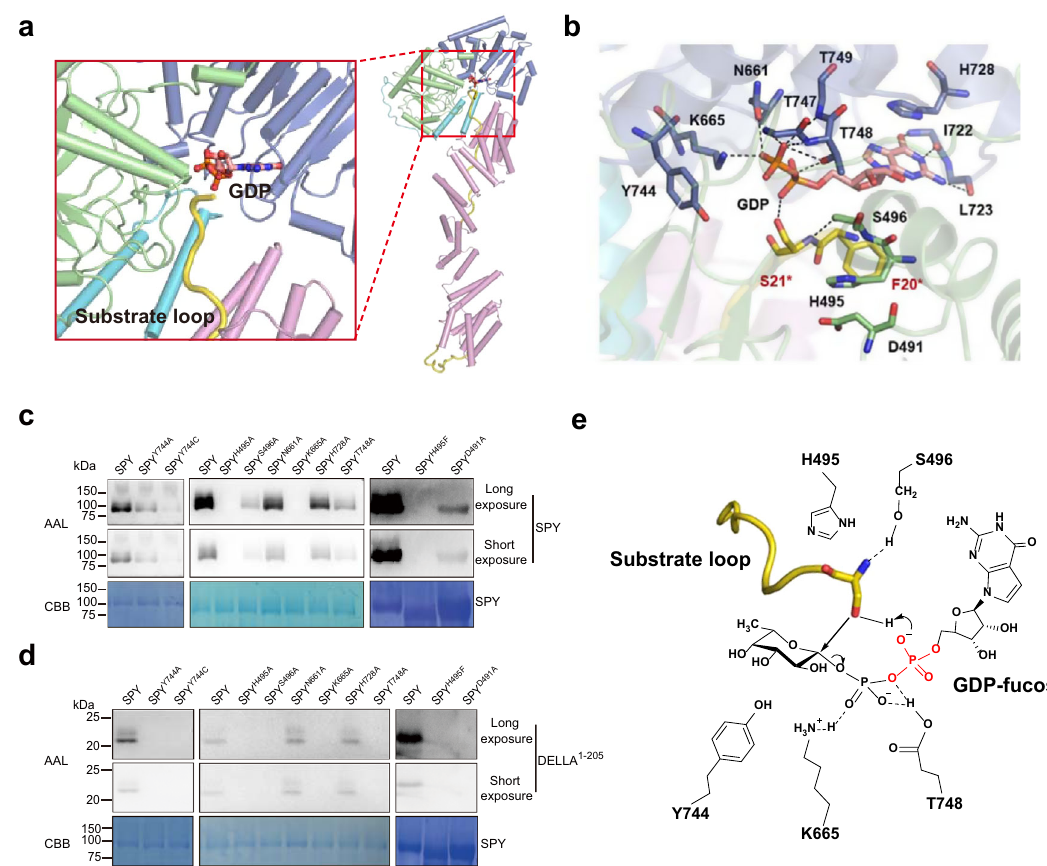
Fig. 4 | Activesiteand catalyticalmechanismofSPY. a Cartoon rendering of the activesiteinthe ‘ catalyticSPY ’ /GDP/ ‘ substrateSPY ’ complex.GDPisshownasstick. The color coding is the same as in Fig. 2a. b Close-up view of the active site in the ‘ catalytic SPY ’ /GDP/ ‘ substrate SPY ’ complex. Residues of interest are shown as sticks. For simplicity, the side chains of I722, L723, T747 and T749 are omitted as they stabilize the GDP with their backbones. Residues in the ‘ catalytic SPY ’ and the substratelooparelabeledinblackandred,respectively.Blackdottedlinesindicate hydrogen bonds. c Self-fucosylation of wild type SPY and mutants carrying point mutations in the active site. Upper panel (long exposure) and middle panel (short exposure) show western blotting with biotinylated AAL. Lower panel shows Coo- massie blue staining. Experiments were independently repeated three times with similar results. Uncropped images of Western blotting membranes and gels are